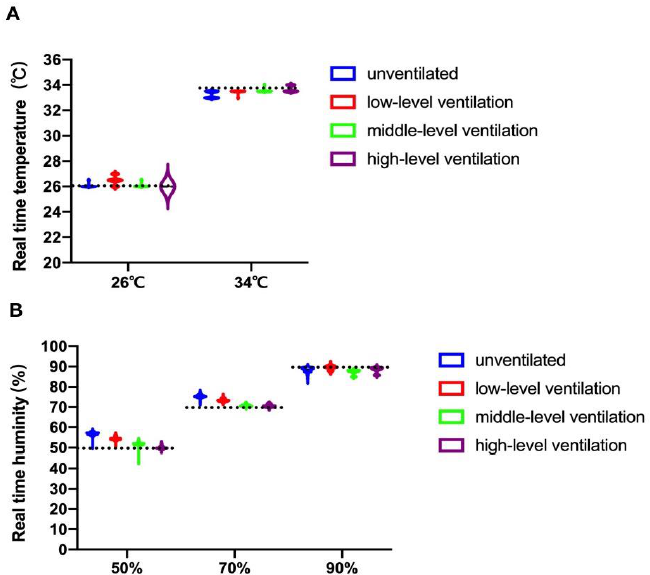
Figure 3. Environmental monitoring of every set of conditions. ( A ) Real-time temperature in each test cabinet with the pre-set chamber temperature of 26 °C or 34 °C; ( B ) Real-time humidity in each test cabinet with the pre-set chamber humidity of 50%, 70%, or 90% RH.